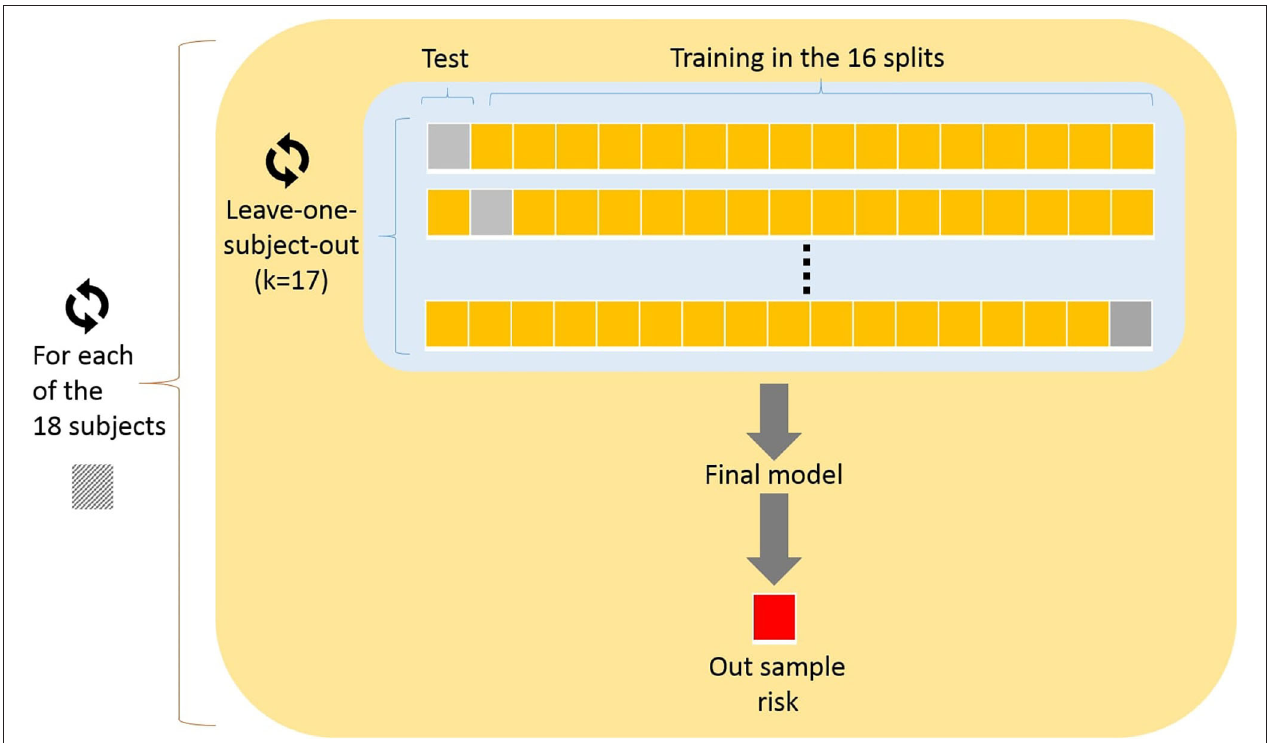
FIGURE 3 | Double cross-validation implemented: In the outer (external) loop of double cross-validation, each interaction excludes one subject and all remaining data subjects are divided into two subsets referred to as training and test sets. The training set used in the inner (internal) loop, while the test set was exclusively used for model assessment.